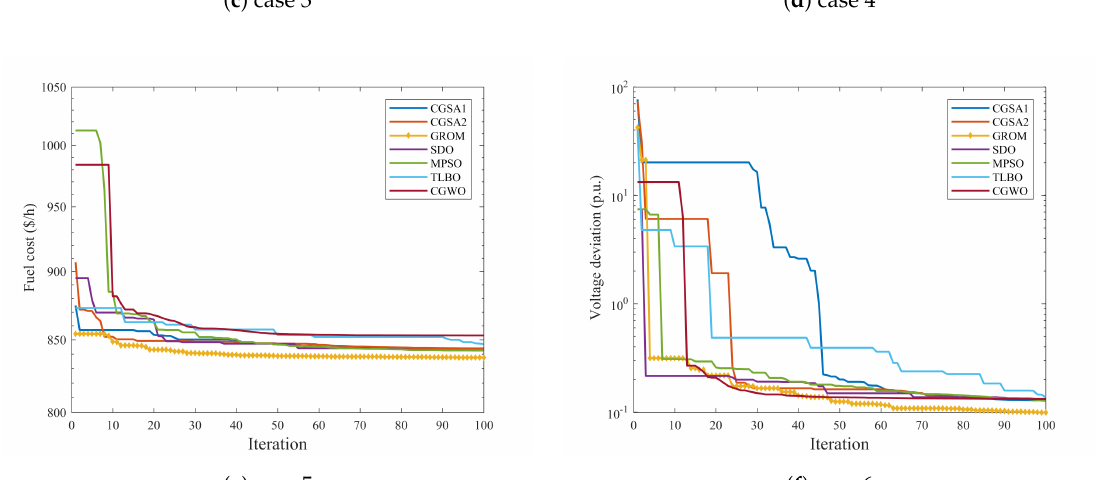
Figure 3. Convergence curves for single-objective optimal power